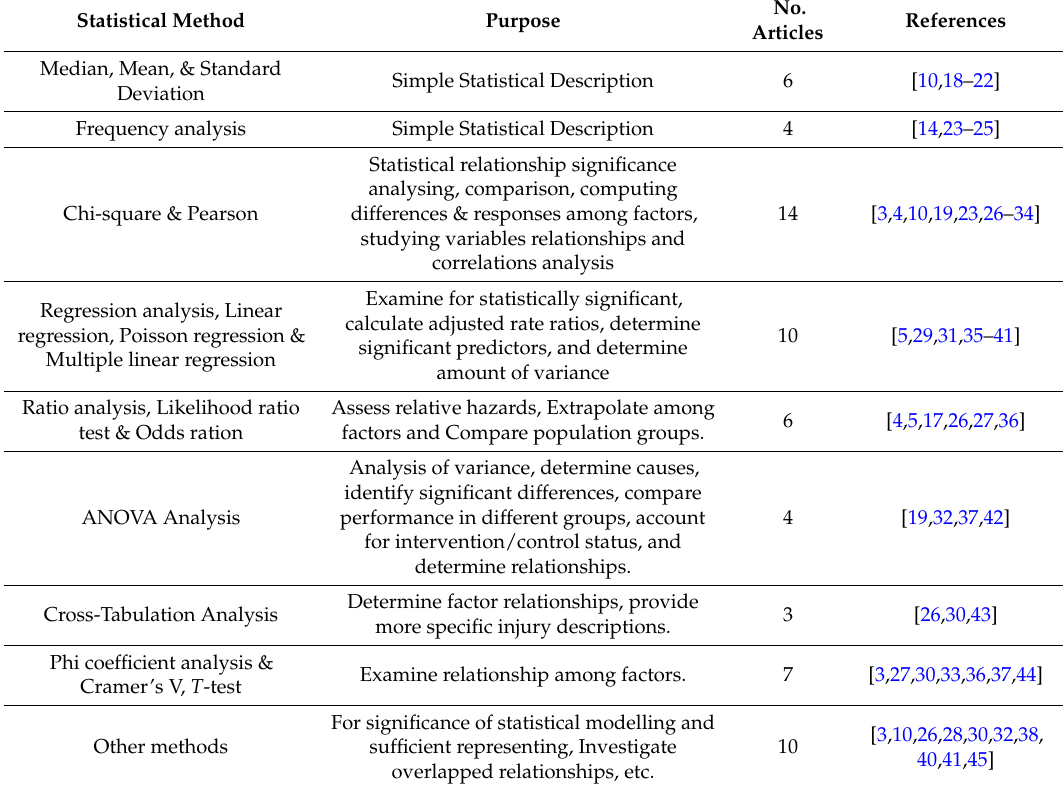
Table 7. Statistical methods used on FFH